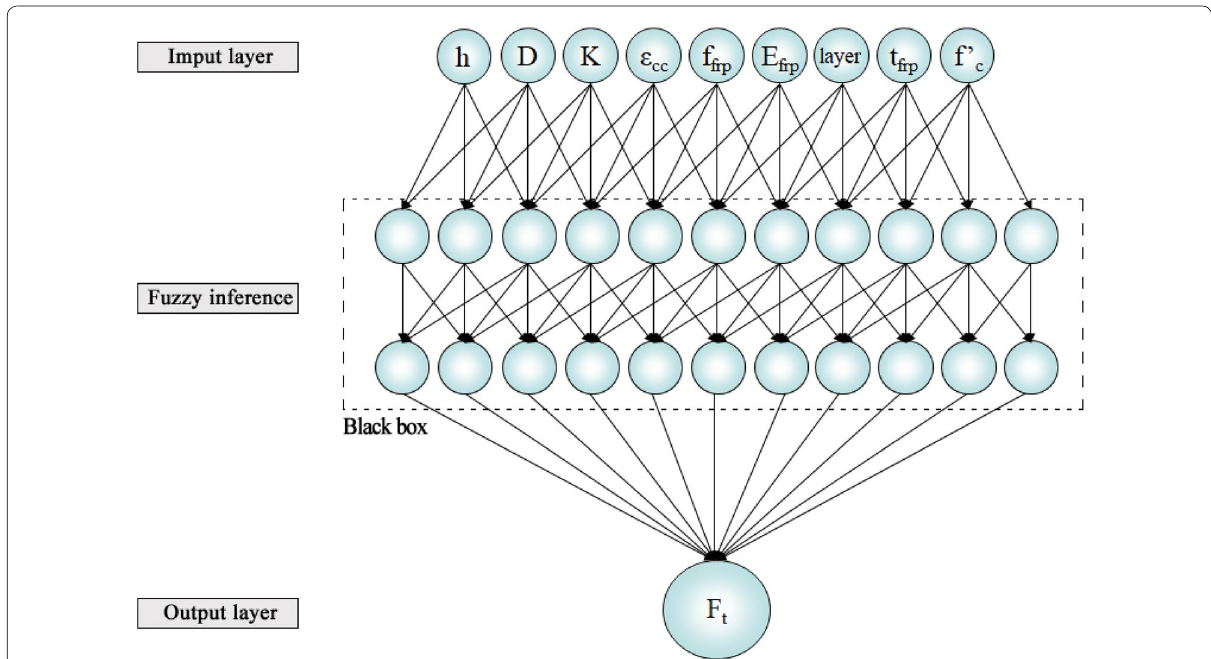
Fig. 3 Fuzzy design for CFRP retrofitting system.